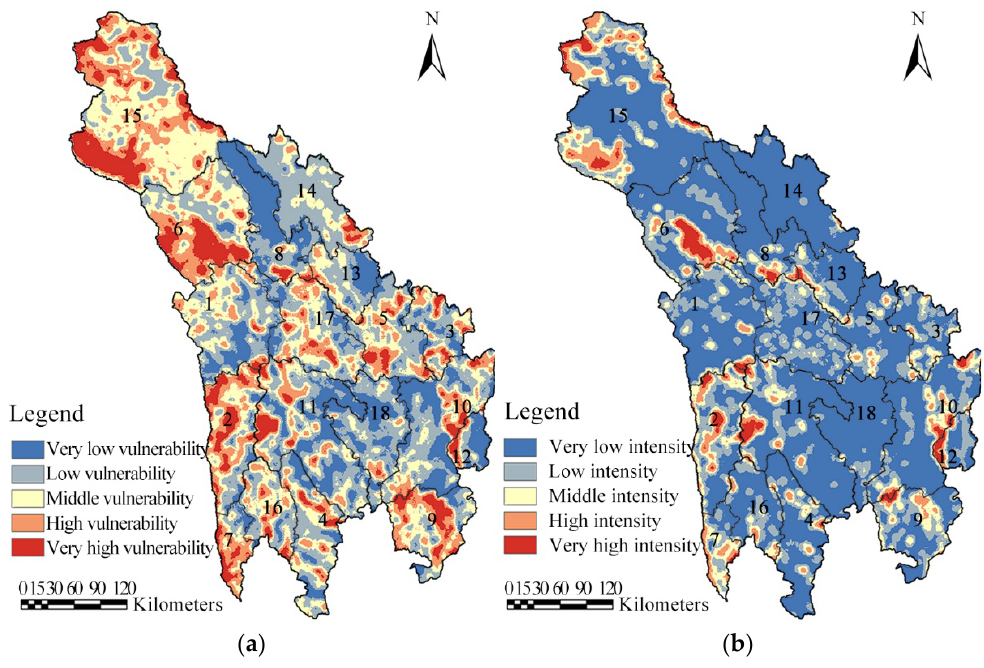
Figure 4. ( a ). Spatial distribution of LVI. ( b ). Spatial distribution of LHAI. Table 5. LVI and LHAI in each county of Ganzi